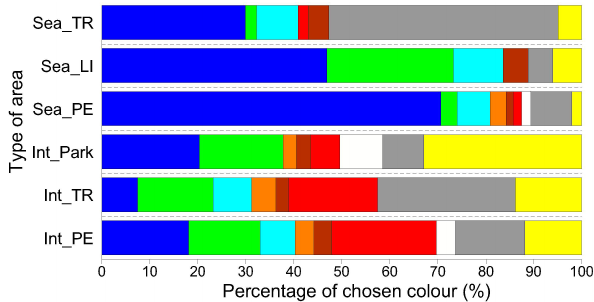
Figure 9: Percentage of people who had chosen a specific colour in the six types of area under study.